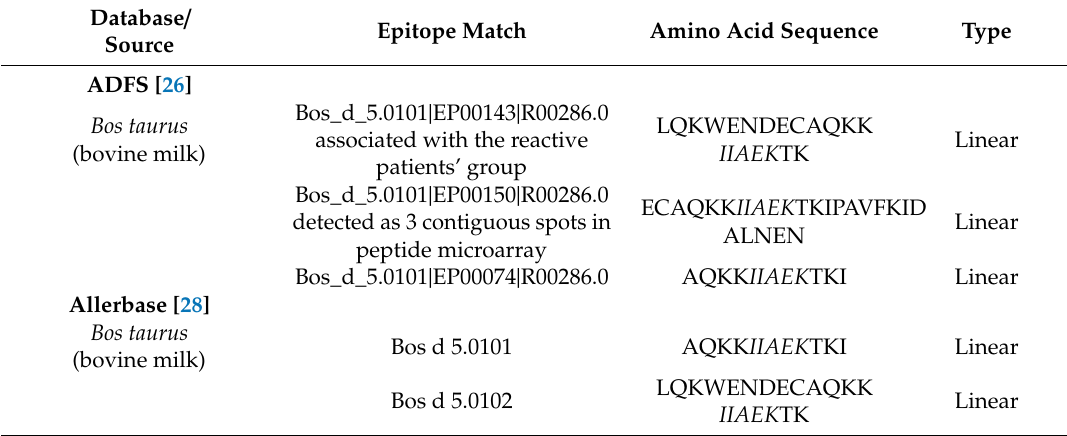
Table 8. Potential allergenicity analysis of the IIAEK peptide with existing IgE-binding